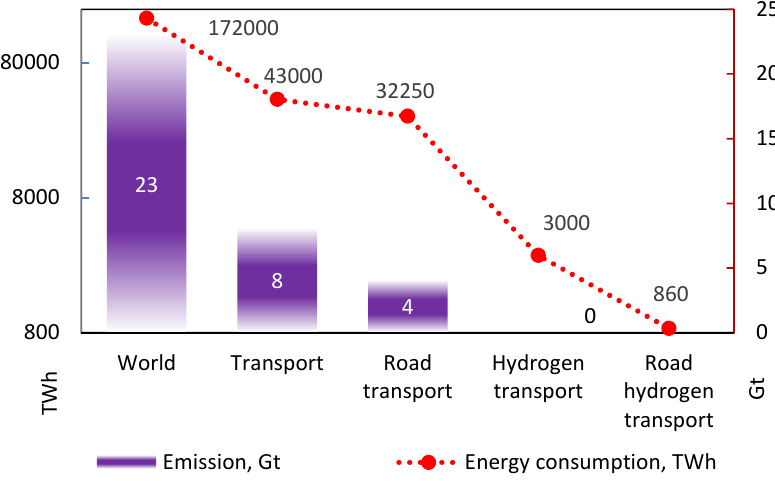
Figure 1. Energy consumption and CO 2 emission of world transport.